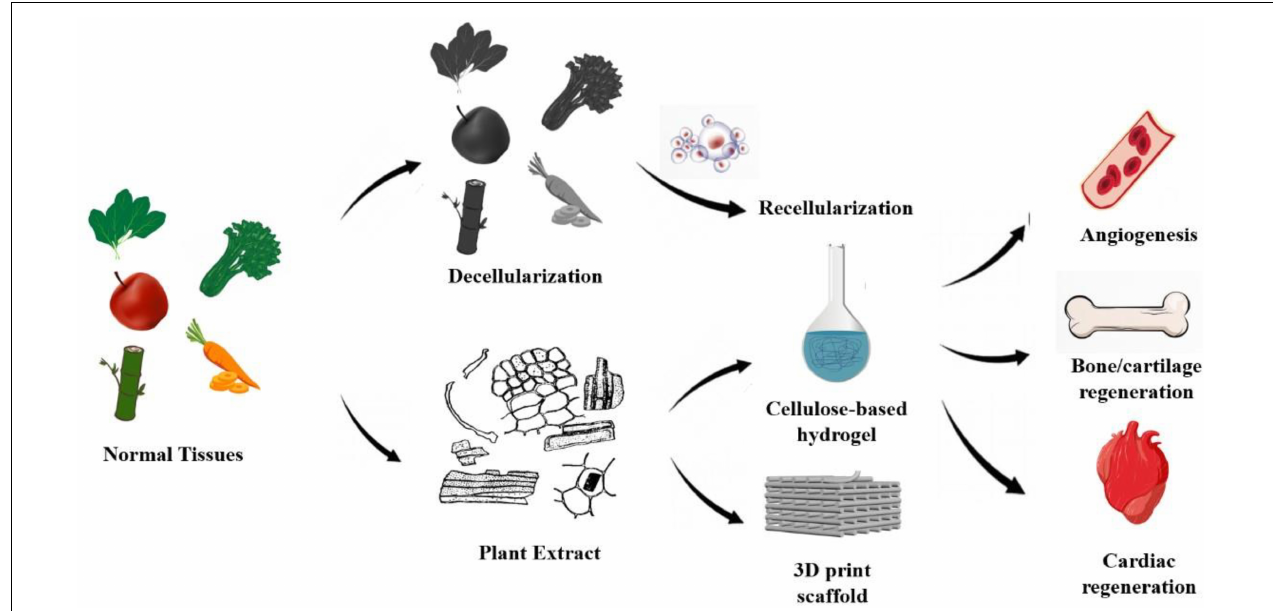
FIGURE 3 | Preparation and application of decellularized plant scaffolds: Current bioactive plant-derived scaffolds (1) recellularization of decellularized plant scaffolds, (2) plant extracts were used for cardiovascular regeneration and bone tissue regeneration by gelation and 3D printing.